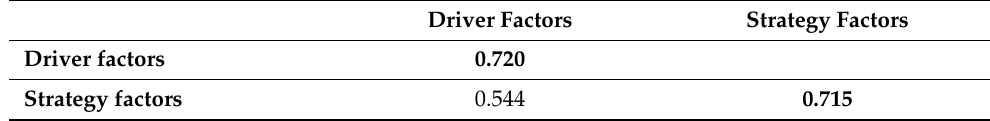
Table 5. Discriminant validity—Fornell–Larcker—driver and strategy factors.